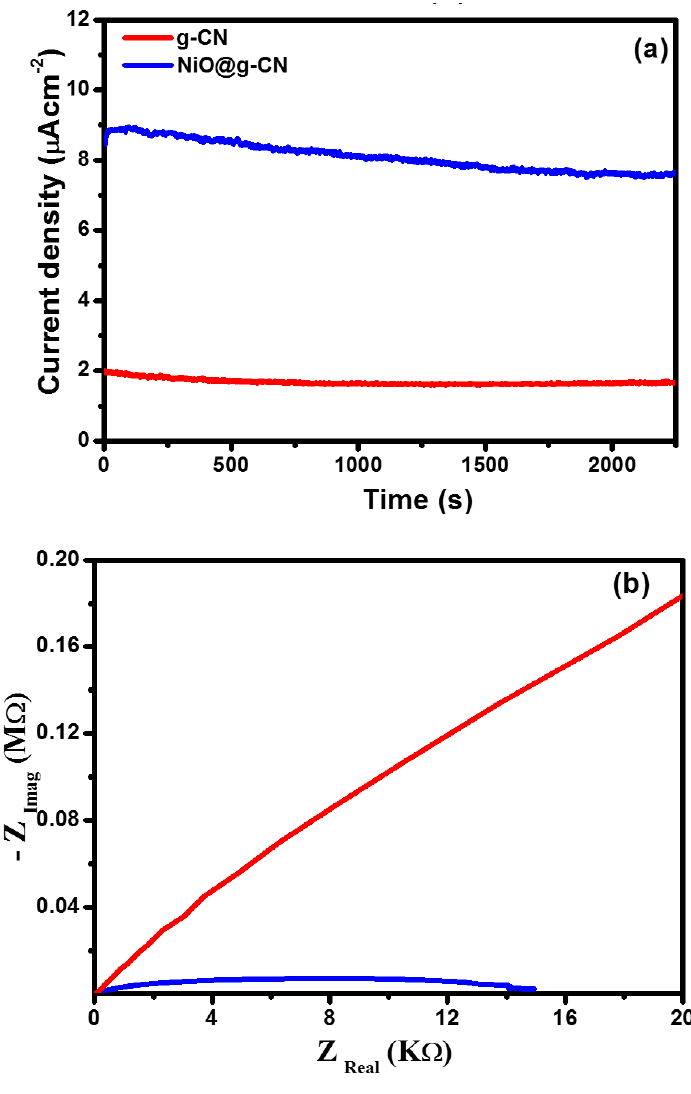
Figure 9. Chronoamperometric stability testing of g-CN and the NiO@g-CN nanocomposite photoanodes under continuous visible-light irradiations ( a ). Nyquist plots of g-CN and NiO@g-CN nanocomposite photoanodes ( b ).